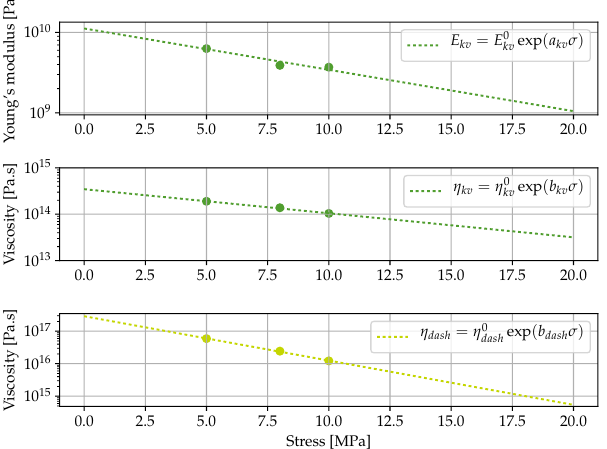
Figure 3. Comparison between the nonlinear functions identified in the present approach and the linear Burgers’ parameters identified at different stress levels by Houhou et al.